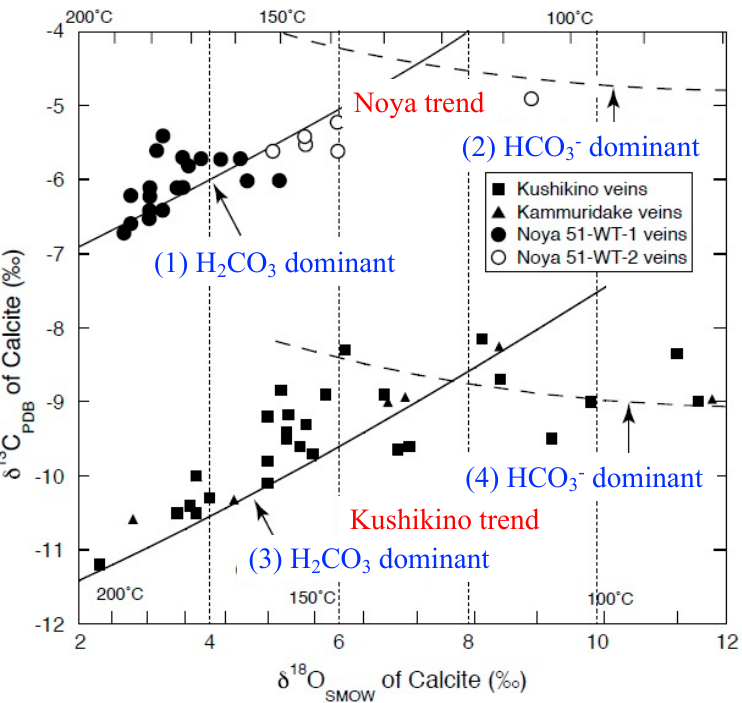
Figure 6. The δ 13 C and δ 18 O values of vein calcite for the Noya and Kushikino deposits (Figure 1). Calculated as a function of temperature, curves (1) and (2) represent equilibrium fractionation trends for calcite under the assumption that H 2 CO 3 [33] and HCO 3 − [34] are the predominant carbon species in the fluid, respectively. The δ 13 C and δ 18 O values of the Noya fluid for both curves are obtained to be –6.5‰ and –7.5‰, respectively [26]. The temperatures marked on the upper x -axis are isotopic equilibrium temperatures [35]. Curves (3) and (4) are equilibrium fractionation trends for calcite from the Kushikino deposit. The δ 13 C and δ 18 O values of the Kushikino fluid for both curves are obtained to be –10.8‰ and –7.0‰, respectively [19]. At about 140°C with decreasing temperature, the predominant carbon species in the Kushikino fluid changed from H 2 CO 3 to HCO 3– [27]. Samples of the Kushikino veins are from the Kushikino deposit, and those of the Kammuridake veins are from a peripheral area of the deposit. The oxygen isotopic equilibrium temperatures for the Kushikino hydrothermal fluid are marked on the lower x -axis.